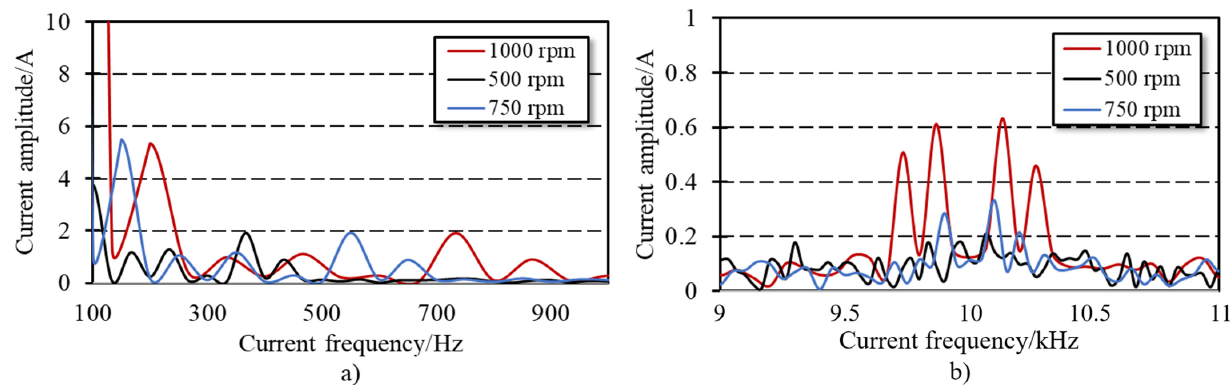
Figure 13. Current harmonics at different speeds: ( a ) the low-frequency band and ( b ) harmonics near the switching frequency.